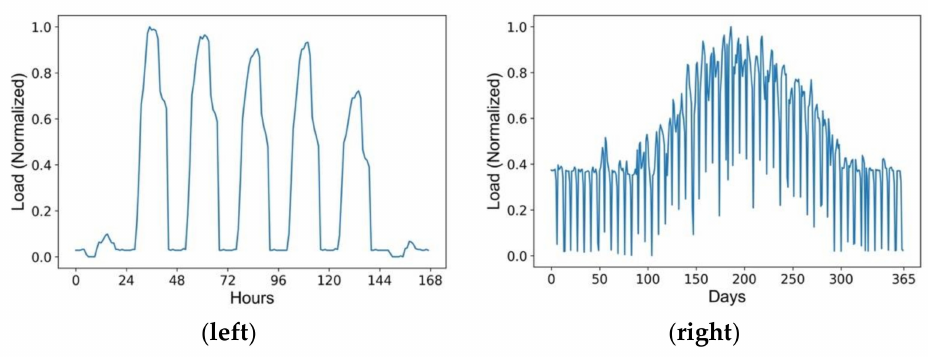
Figure 7. Examples of weekly power load curve ( left ) and annual power load curve ( right